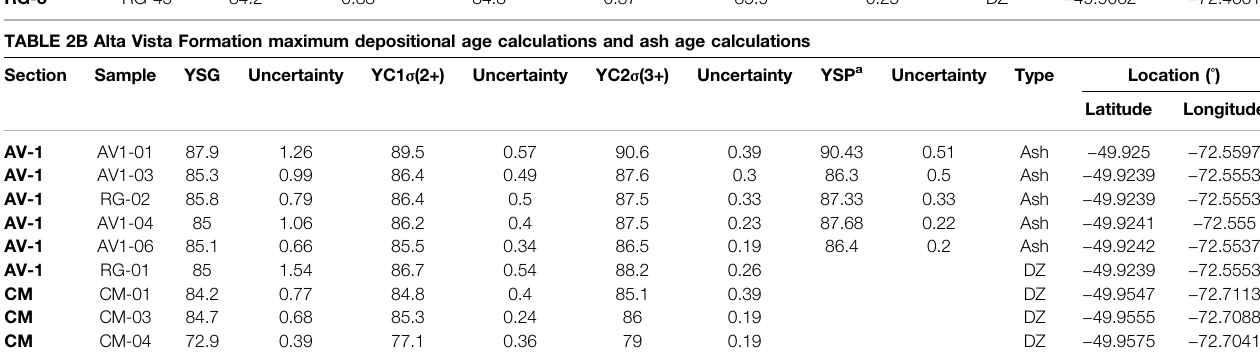
TABLE 2B Alta Vista Formation maximum depositional age calculations and ash age